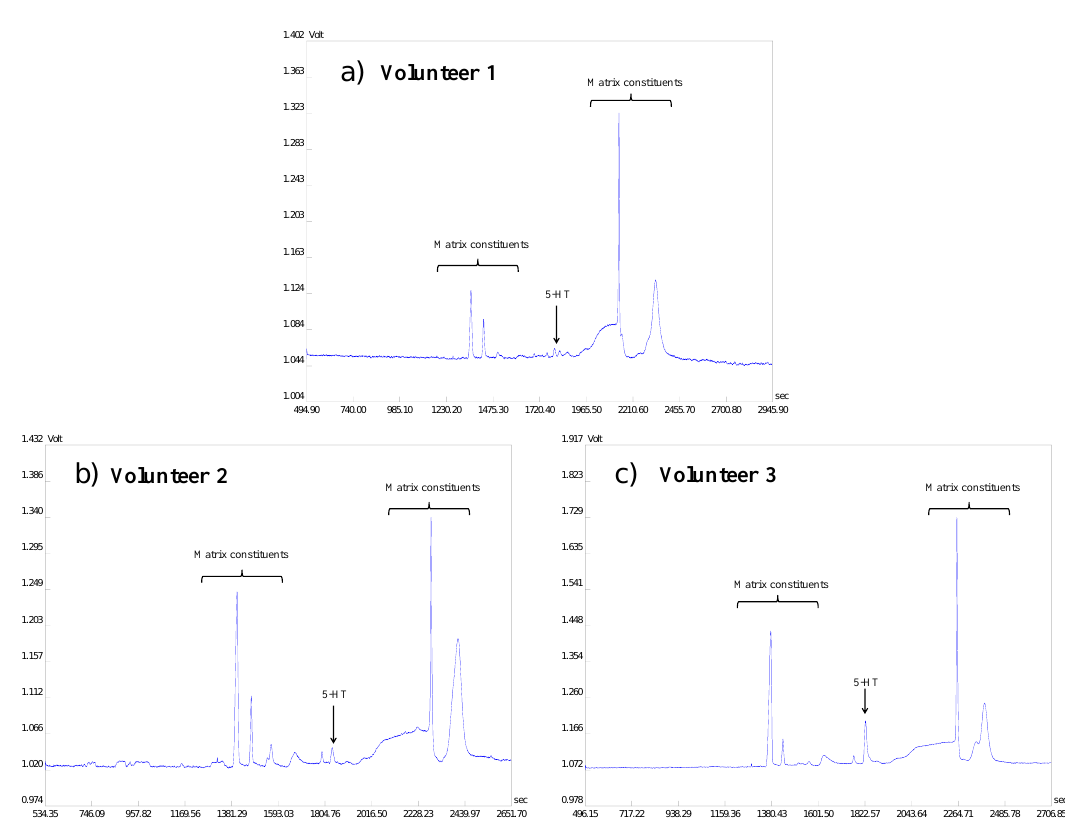
Figure 3. Electrophoretic profiles of urine samples taken from volunteers for screening of 5-HT concentrations. Concentration levels of 5-HT in urine samples obtained from three healthy volunteers ( a – c ) ranged in the interval of 12.36–491.23 ng · mL − 1 . The human urine samples were diluted 10 times. For the instrumental parameters and optimum ITP and CZE separation conditions see Sections 3.1.